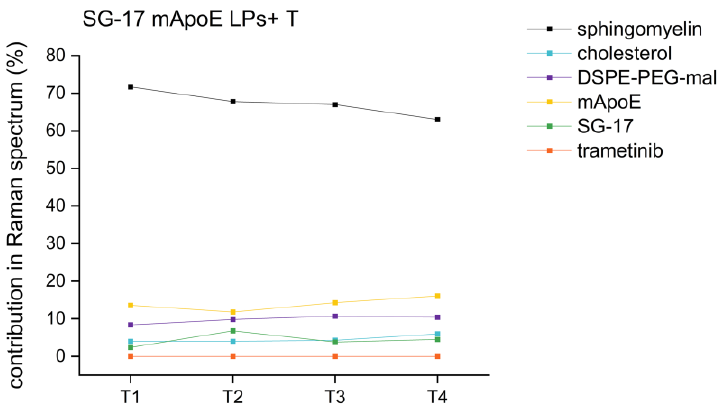
Figure 7. Percentage trends of different LP components in the same formulation (SG-17 mApoE LPs + T) at T1 (one week), T2 (two weeks), T3 (three weeks), T4 (four weeks) after their synthesis.